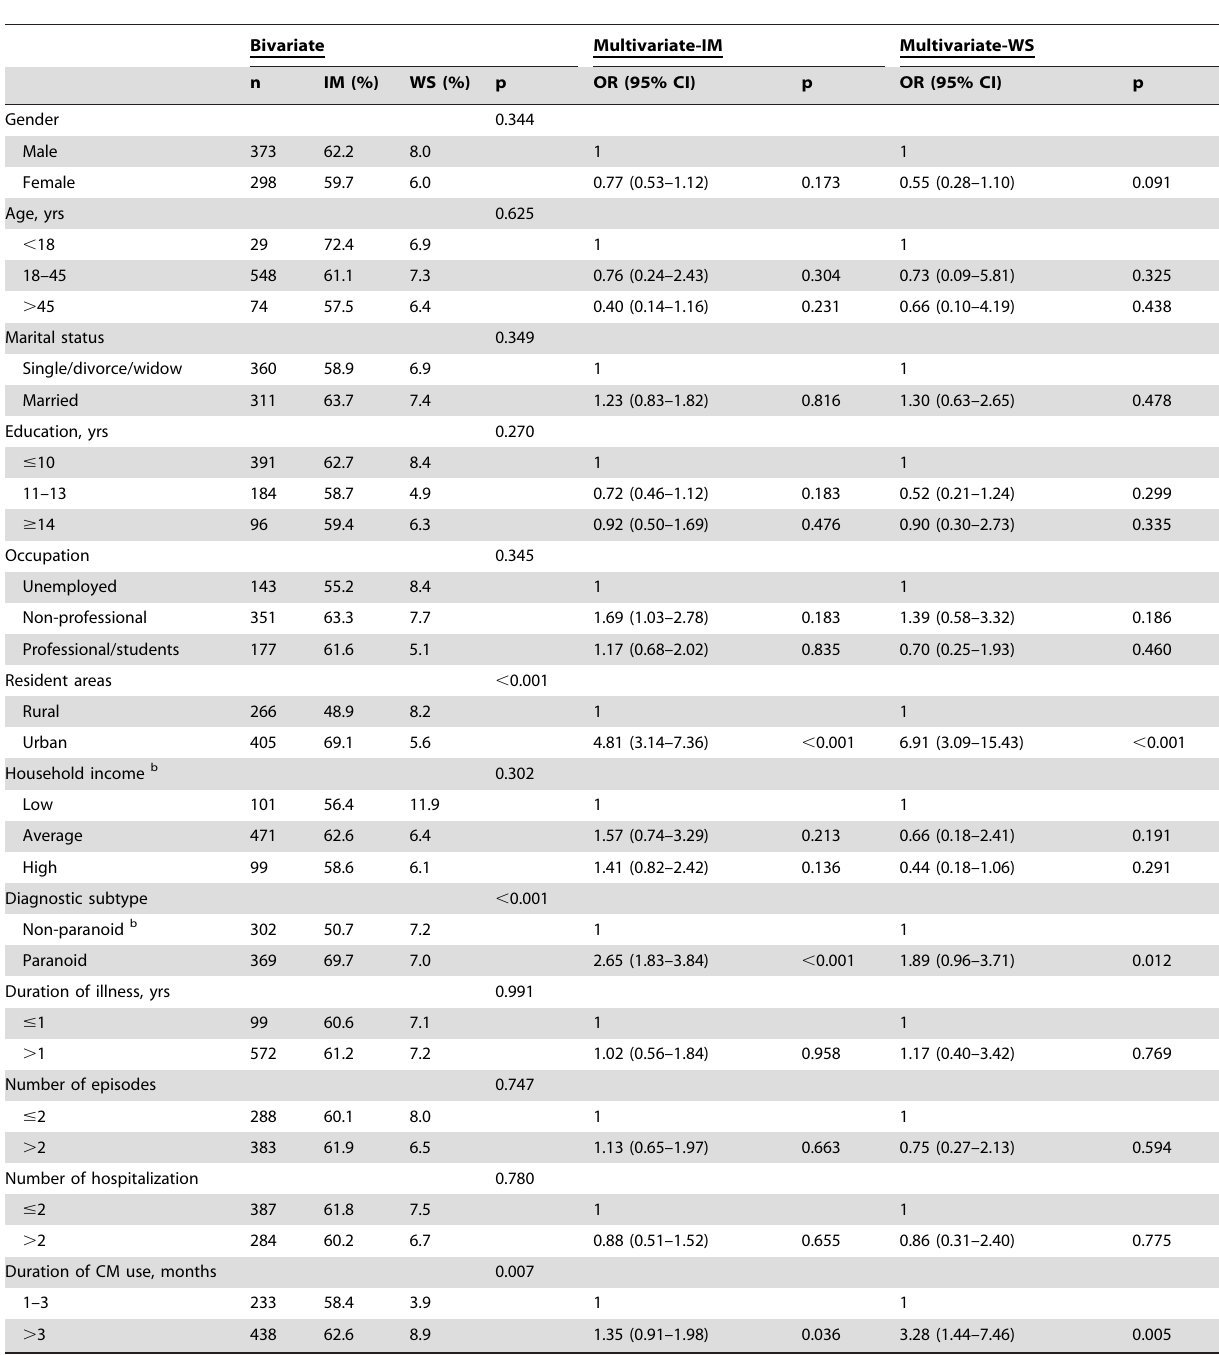
Table 3. Bivariate and multivariate associations of clinical outcomes with demographic and clinical variables in schizophrenic patients in Chinese medicine and antipsychotic concomitant treatment.